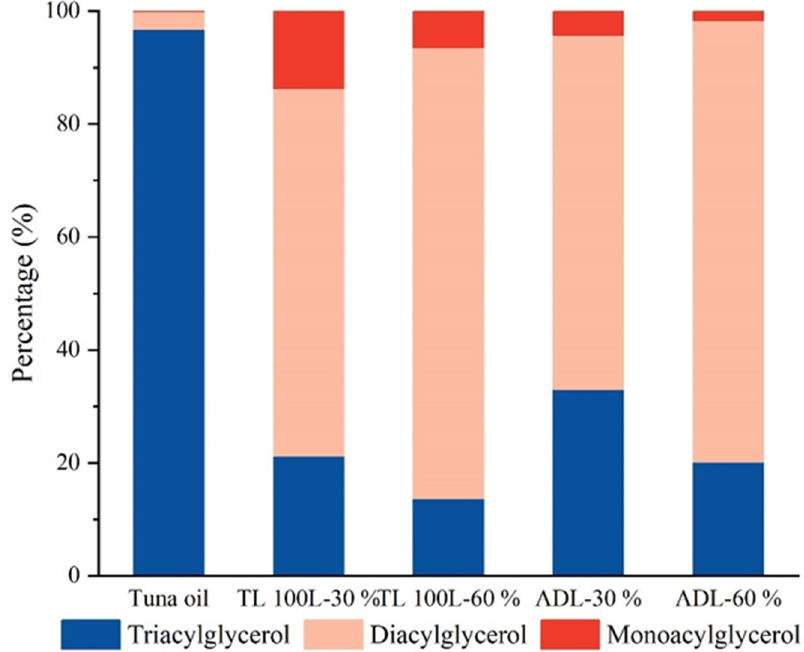
Figure 2. Percentage of acylglycerol composition in tuna oil and its hydrolyzed acylglycerols. Cluster Heatmap Analysis of TAG, DAG and MAG